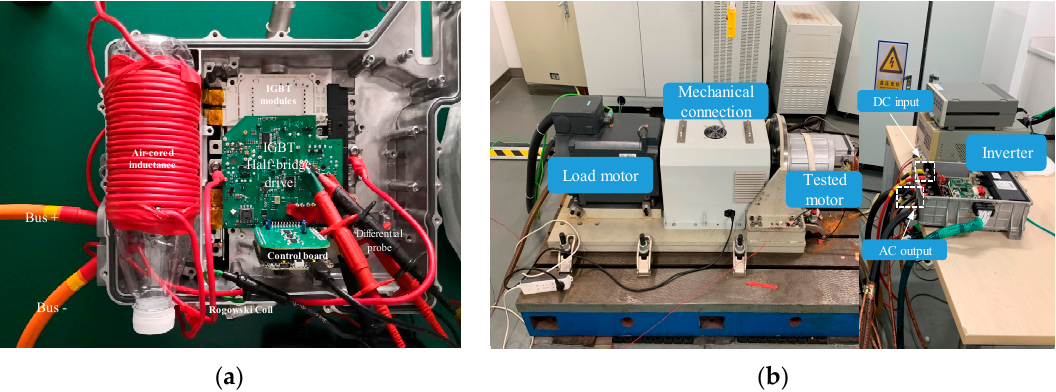
Figure 9. The experiment equipment. ( a ) The double-pulse test equipment. ( b ) The permanent magnet synchronous motor (PMSM) test